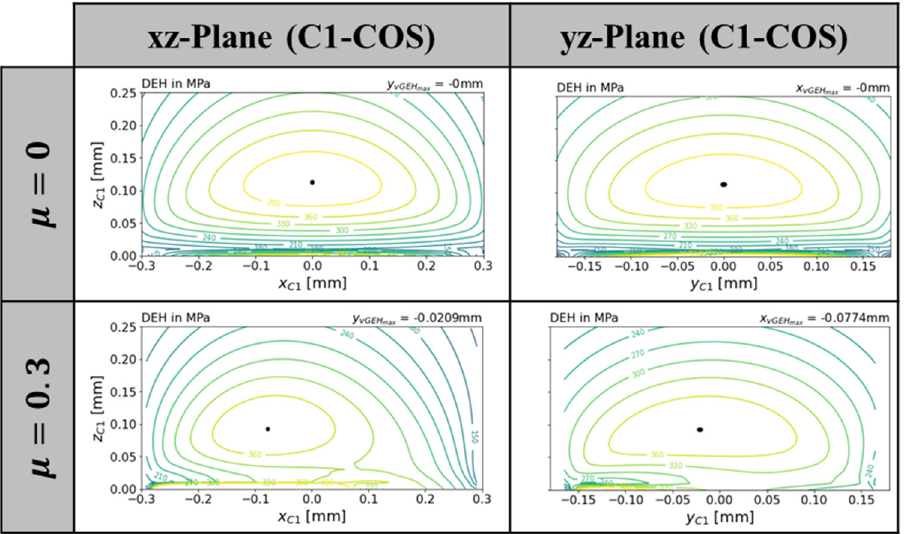
Figure 7. Equivalent stress distribution DEH for the material pair steel/steel, F rad = 200 N, F ax = 30 N, free rolling.